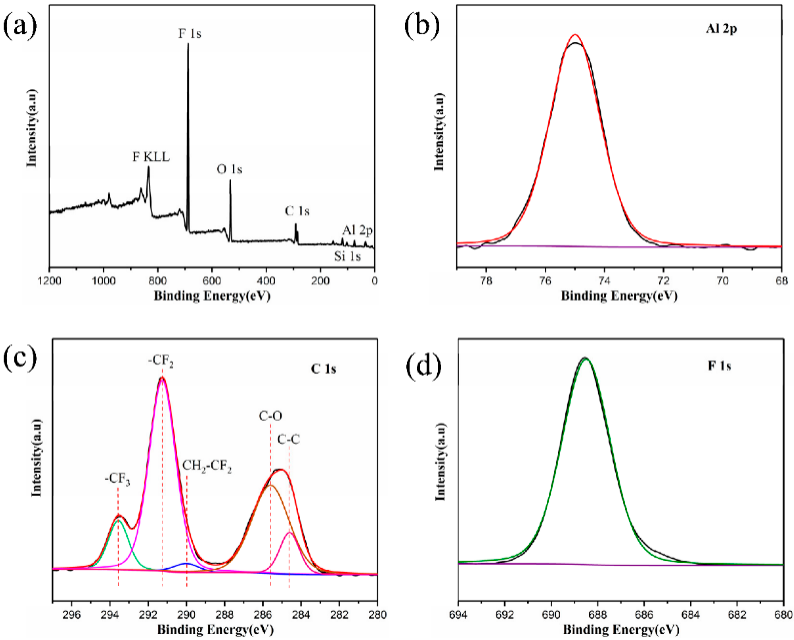
Figure 3. XPS spectra of the SHS: ( a ) XPS survey spectra; ( b ) high resolution of Al 2p; ( c ) high reso ‐ lution of C 1s; ( d ) high resolution of F 1s. resolution of C 1s; ( d ) high resolution of F